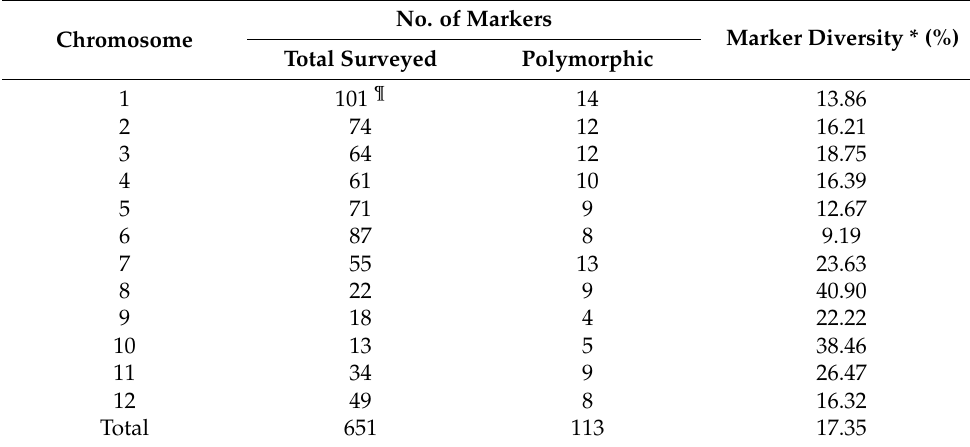
Table 1. Genome wide marker polymorphism between the recurrent parent, Pusa Basmati 1 (PB1) and donor parent, Nagina 22